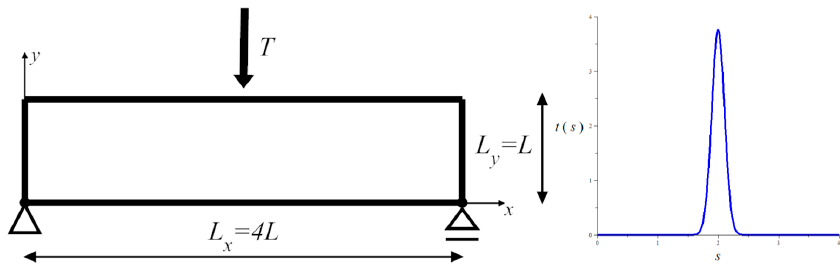
Figure 1. The plate supported at two bottom corner nodes and loaded with one vertical force applied to the upper face ( left ); and modeled by a smoothing weight function ( right ).